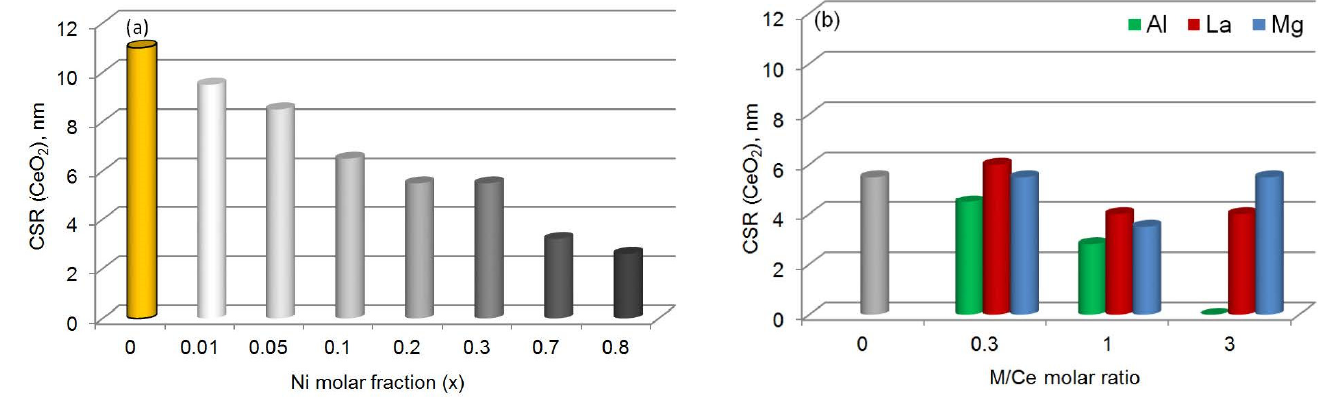
Figure 7. Effect of Ni molar fraction ( a ) and M/Ce molar ratio ( b ) on the CSR value of a CeO 2 -based phase in (CeM) 1 − x Ni x O y (M = Al, La, Mg) samples. ( a )—M/Ce molar ratio is equal to 0; ( b )—Ni molar fraction is equal to 0.2.